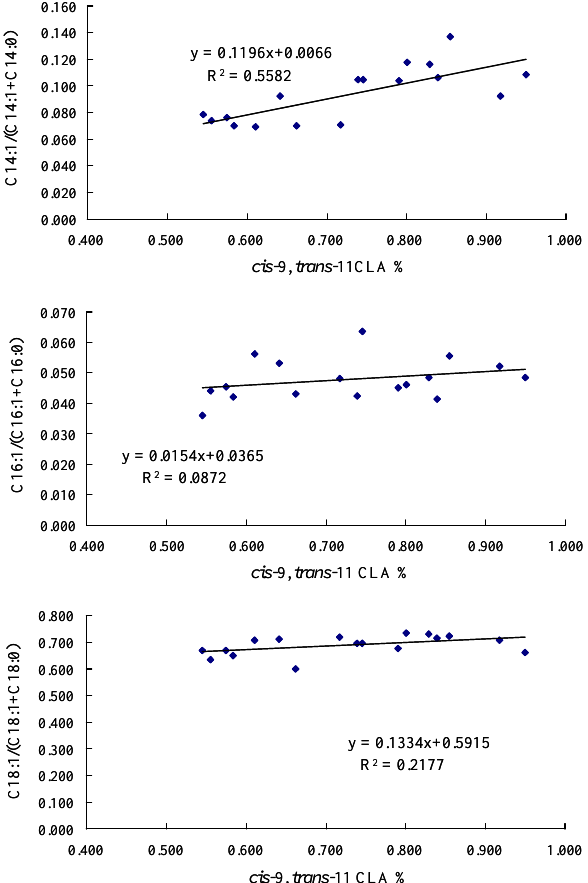
Figure 3. Correlation between cis- 9, trans- 11 CLA content and desaturation indexes (Experiment